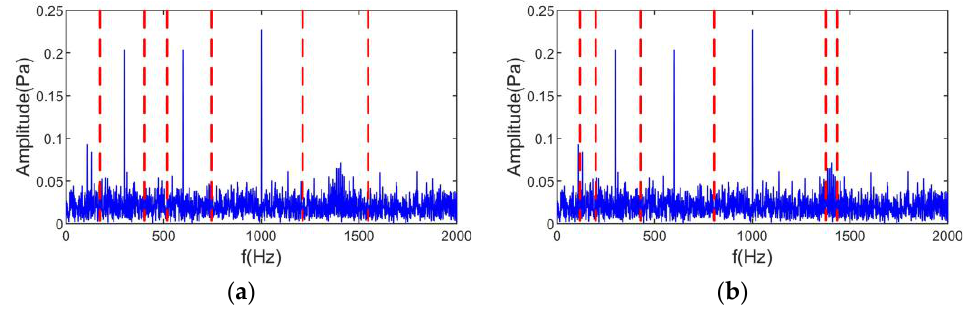
Figure 6. Spectral division results: ( a ) CSSVMD, ( b ) CSSEWT .